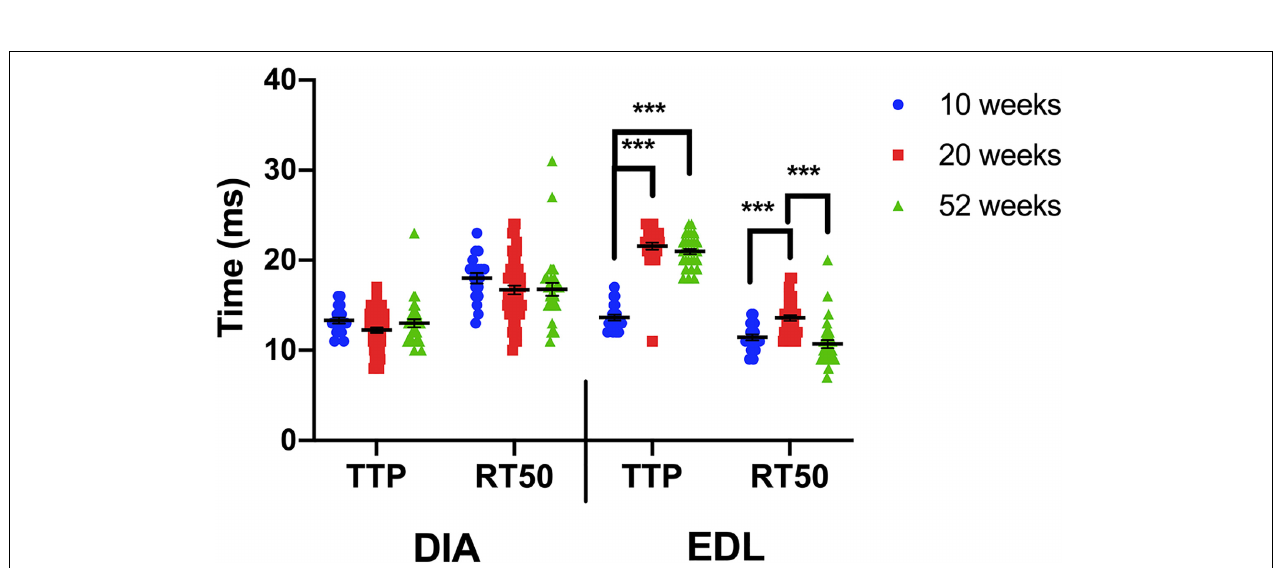
FIGURE 4 | Time to peak and 50% relaxation of wildtype diaphragm and EDL muscles at 10, 20, and 52 weeks of age. Kinetic analysis was conducted in diaphragm and EDL muscles of C57BL/10 mice. The data shown in this figure is the same as in previous figures but is formatted in a manner to compare kinetics with increasing age. Statistical analysis was conducted using a one-way ANOVA. *** indicates P < 0.001. The line represents the group mean; error bars are standard error of